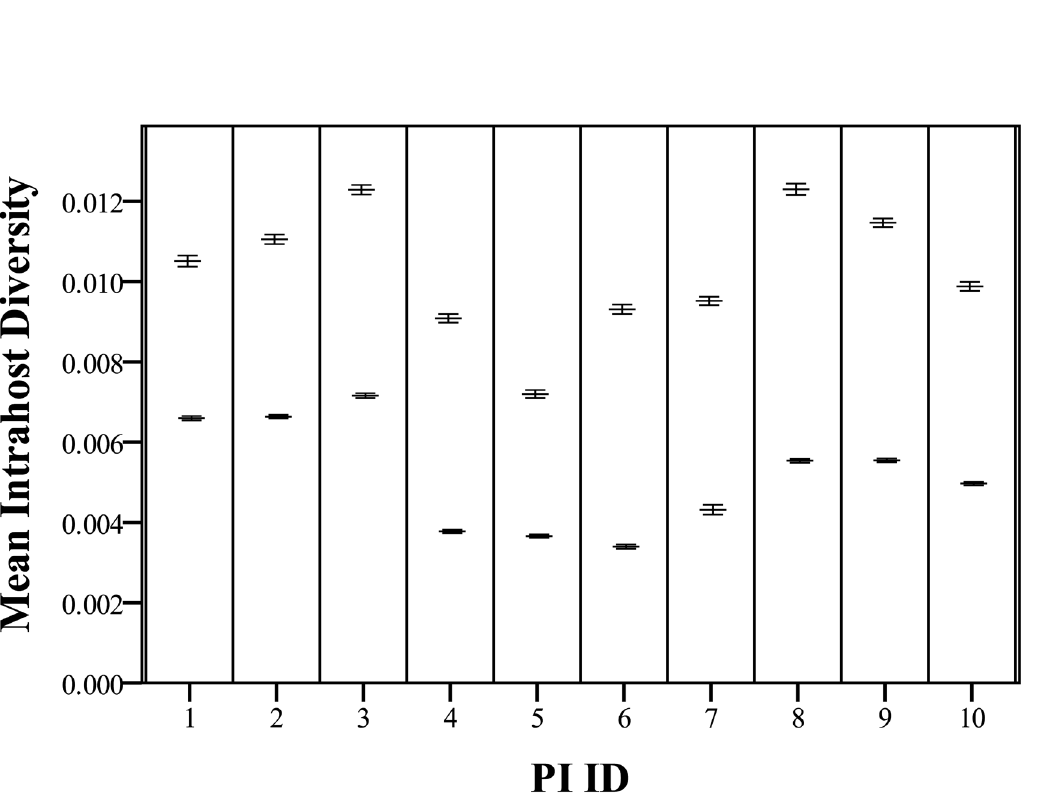
Fig 1. Mean total intrahost E2 (upper bar) and NS5B (lower bar) distances for each PI animal. Distance are based on a minimum of 70 sequences per gene per animal. Horizontal bars indicate the mean distances and the error bars represent the standard error of the mean (SEM). See S2 Table for the exact